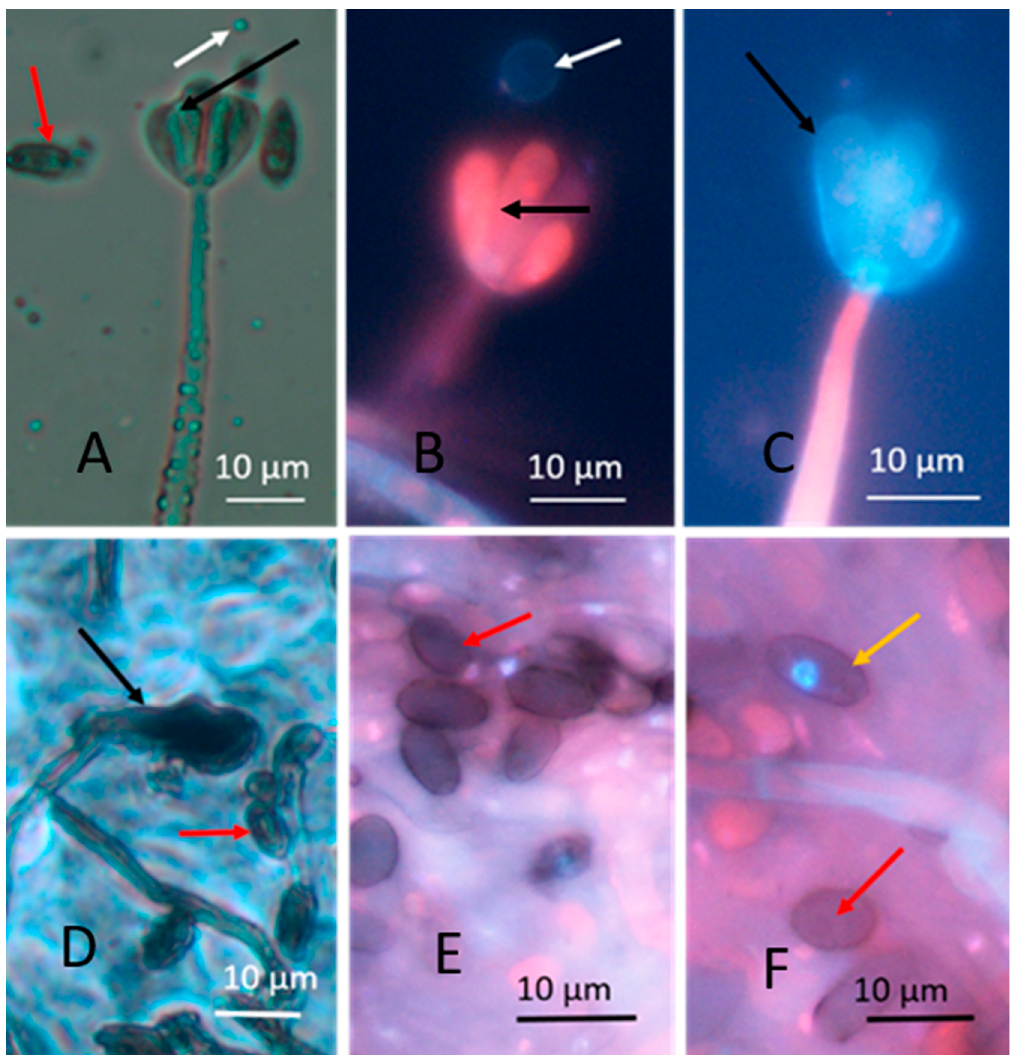
Figure 3. Micrographs made by phase contrast ( A , D ) and epifluorescence microscopy ( B , C , E , F , stained with Hoechst 33342 and propidium iodide). Micrographs show young fresh (upper row) and old dormant (lower row) hyphae and conidia of Stachybotrys sp. strain HJ5 grown on malt extract agar. The fresh mycelium in the upper row has grown for 10 days, while the dry mycelium in the lower row for 6 months. Black and red arrows show conidiophores ( A ) and conidia ( B ), respectively. In Panels ( B , C ) and ( E , F ) the mycelia are ( A ) possible emission of liquid droplets (white arrow); ( B ) conidiophore and phialide stained red (black arrow) and an emitted particle slightly stained blue (white arrow); ( C ) blue stained phialide (black arrow); ( E , F ) no fluorescent mycelium, conidiophores or conidia, the dark dormant conidia (red arrows) and the dehydrated mycelia are impermeable to the fluorescent dyes, except for one conidium with a blue-stained nucleus (( F ), yellow arrow).